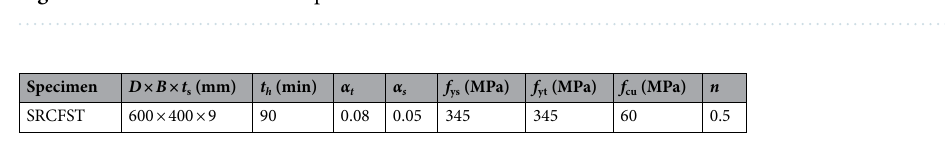
Table 3. Detailed information of SRCFST column. D is the length of the rectangular section, B is the width of the rectangular section, t s is the thickness of the steel tube, t h is the heating time, α t = A t / A c ( A t is the section area of the steel tube, A c is the section area of concrete) is steel tube ratio, α s = A s / A c ( A s is section area of profiled steel) is profiled steel ratio, f ys is the yield strength of profiled steel, f yt is the yield strength of steel tube, f cu is concrete cubic compressive strength, n is the axial compression ratio.